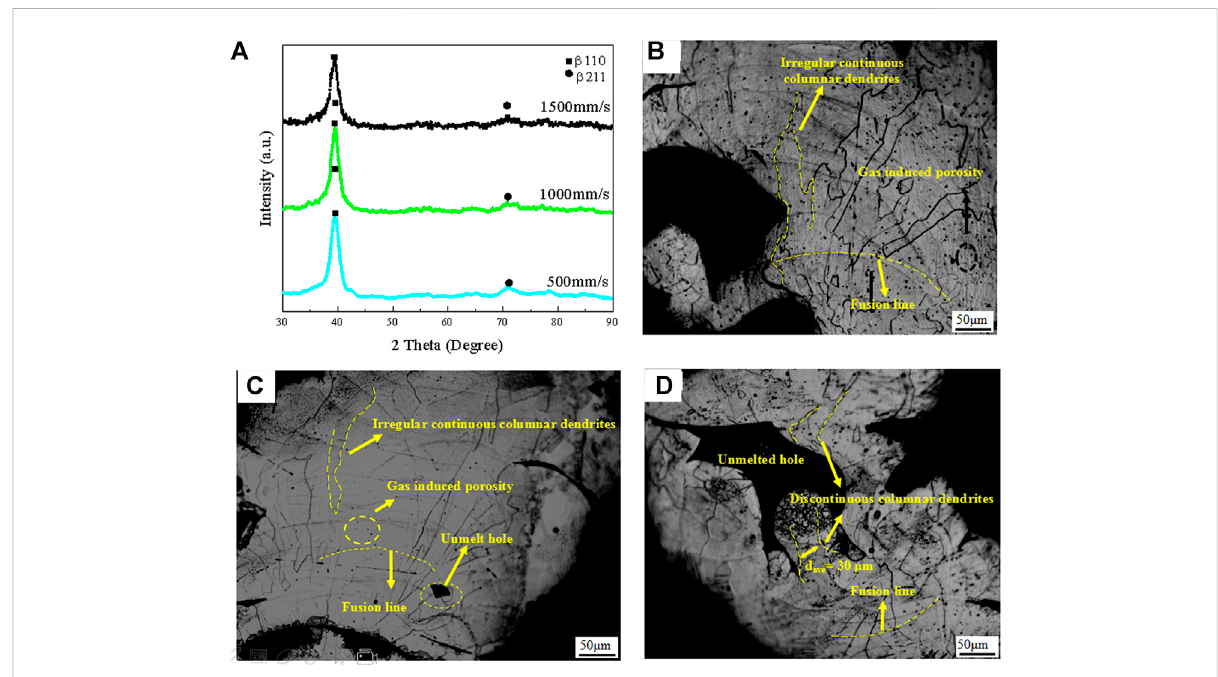
FIGURE 3 XRD pro fi les (A) , optical micrographs of materials built at 500 mm/s (A) , 1000 mm/s (B) , 1500 mm/s (C)